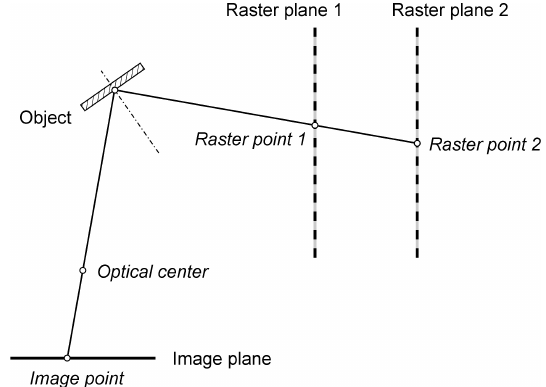
Figure 2. Principle of an enhanced deflectometric approach using two reference pattern positions (Tutsch et al., 2011).